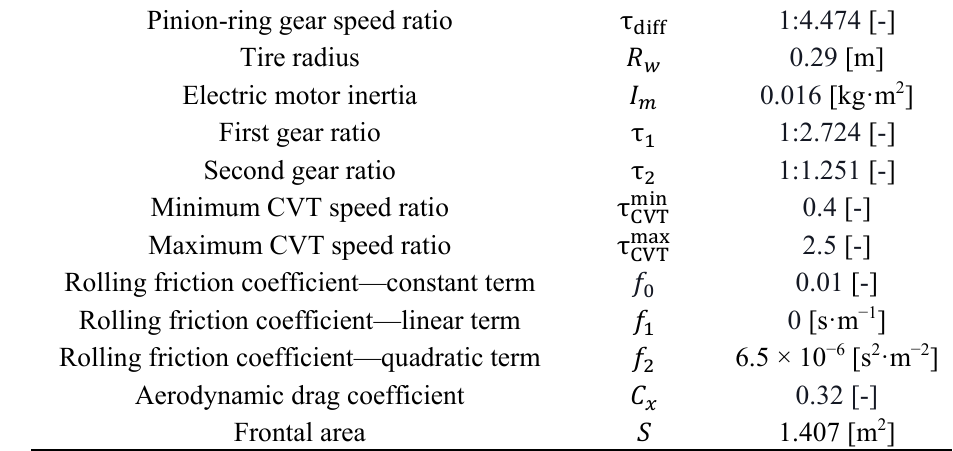
Table 1. Vehicle parameters [7].